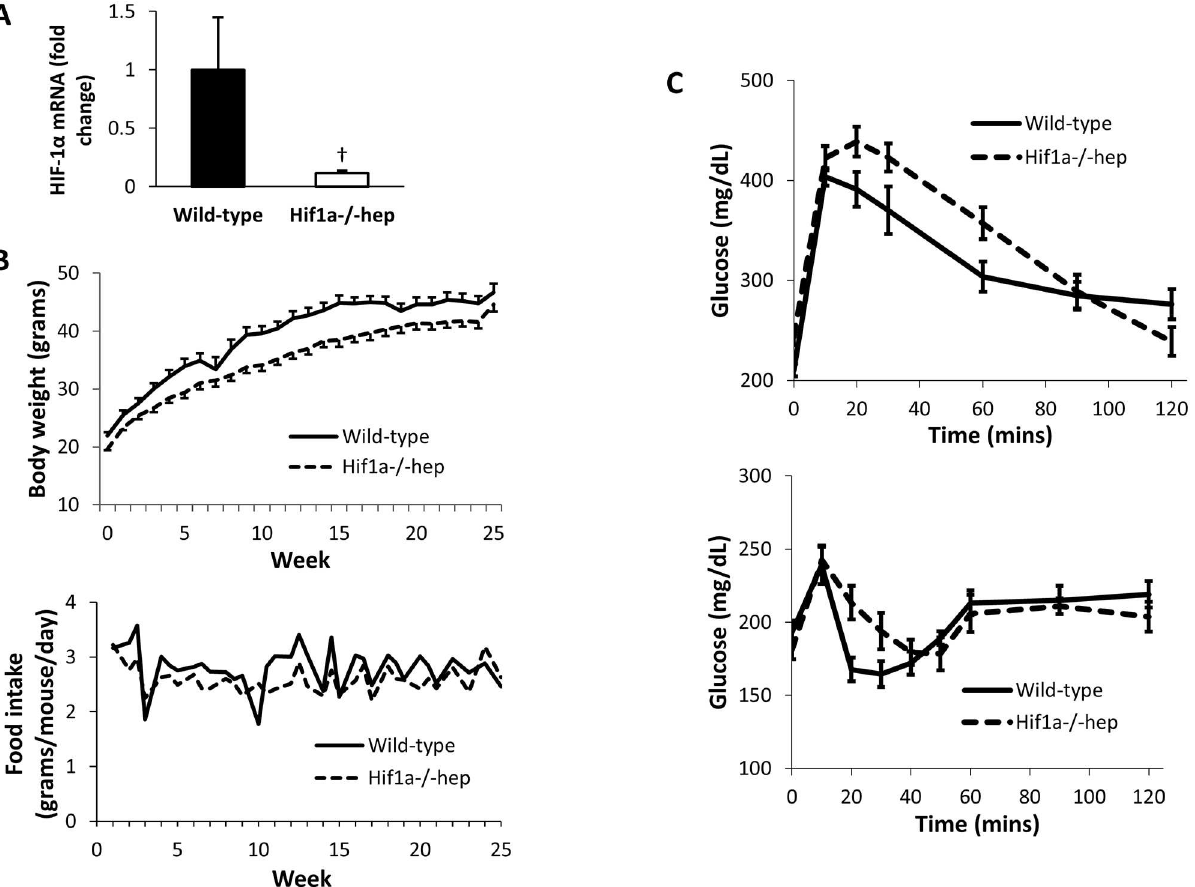
Fig 2. Metabolic characteristics of wild-type and Hif1a -/- hep mice. (A) Hepatocyte knockout of HIF-1 α was confirmedby quantifying HIF-1 α mRNA expressionfrom the nuclear extract of isolatedhepatocytes. (B) Body weight (top) and food intake (bottom) over experiment duration. (C) IPGTT (top) and ITT (bottom) at time of sacrifice. †, p < 0.005.